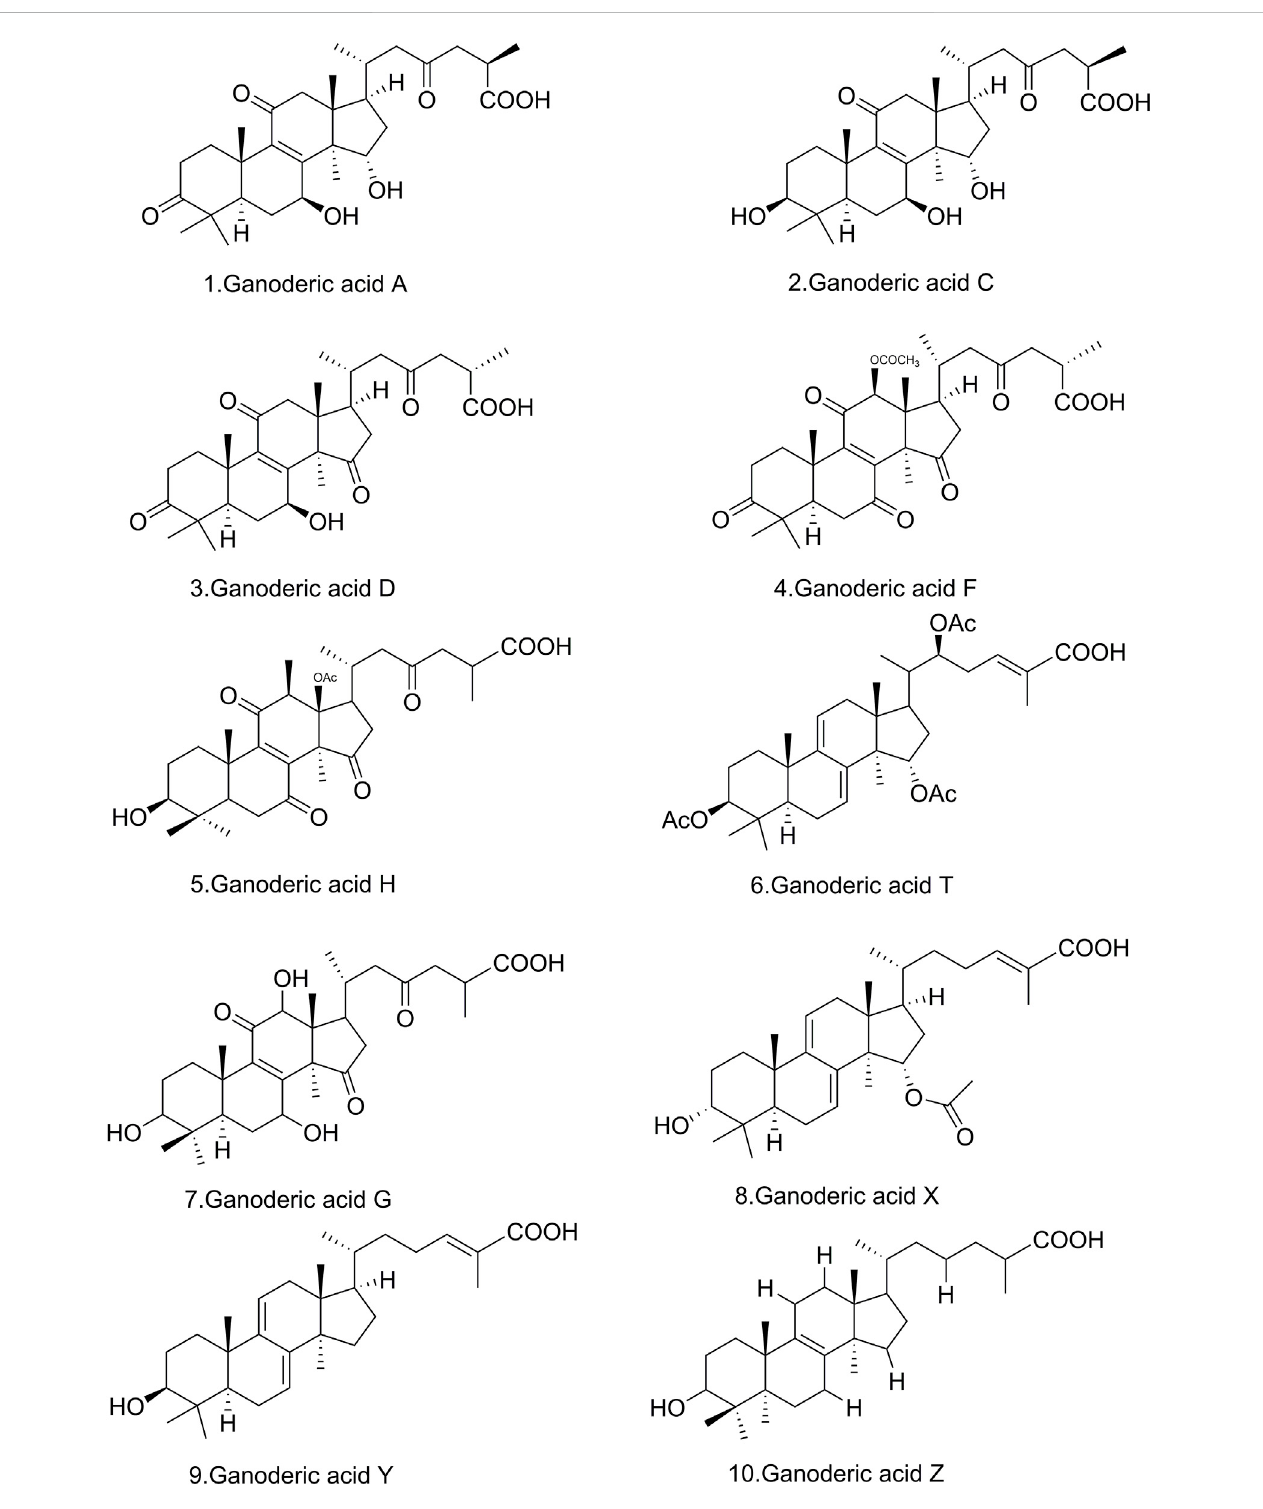
FIGURE 1 Chemical structure of the main active components of Ganoderma